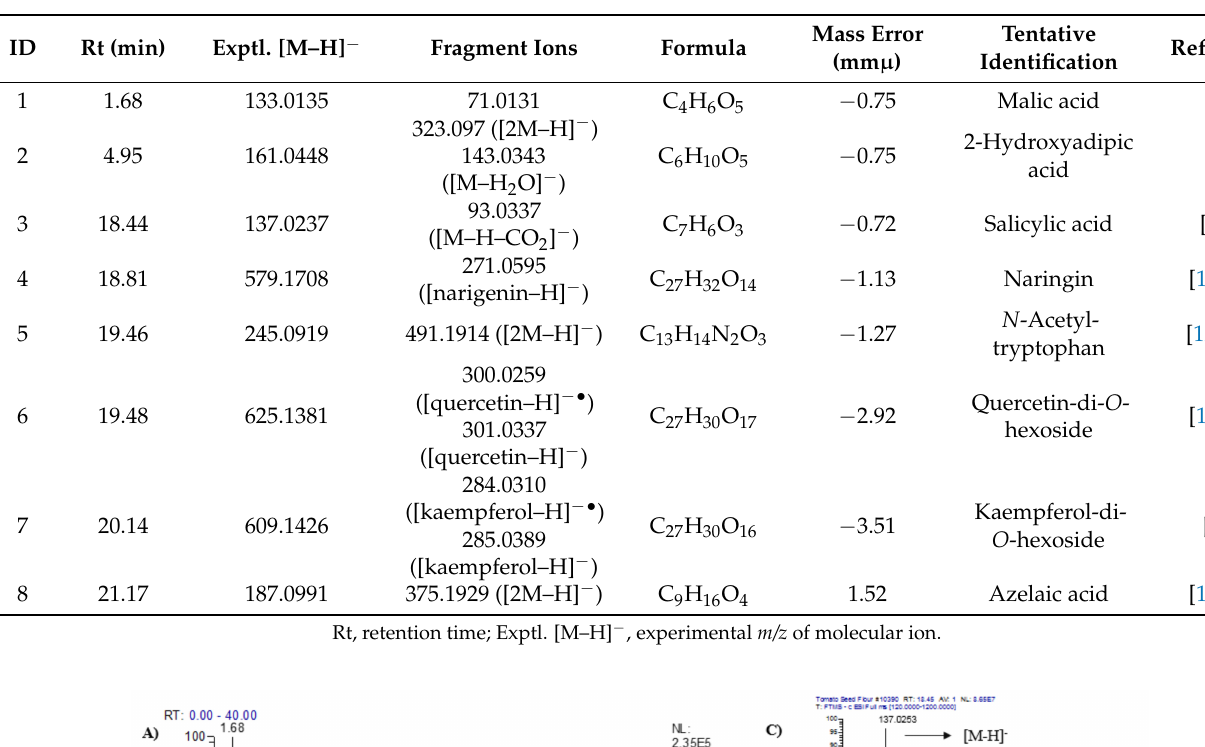
Table 1. The characterization of compounds present in tomato seed flour extracts.